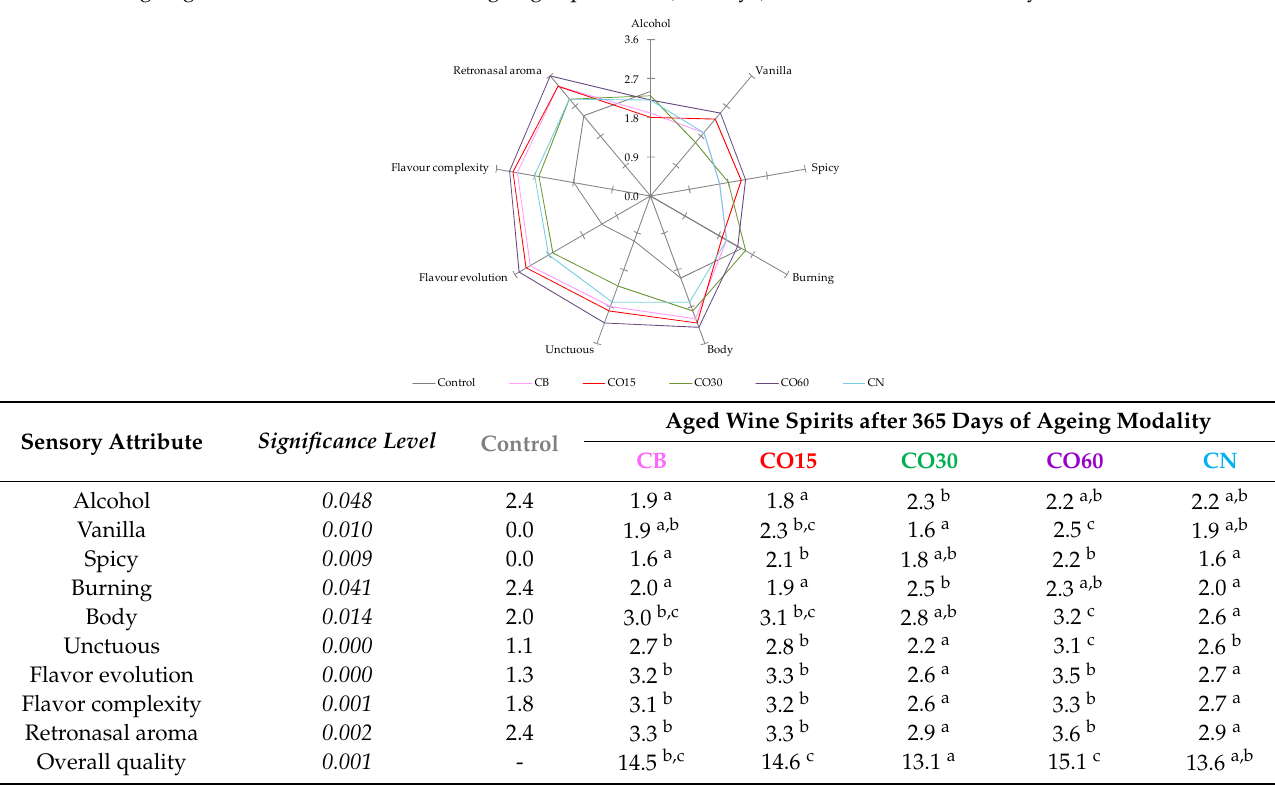
For each sensory attributte of aged wine spirit samples, means within the same row followed by different upperrcase letters ( a , b , c ) are significantly different ( p <